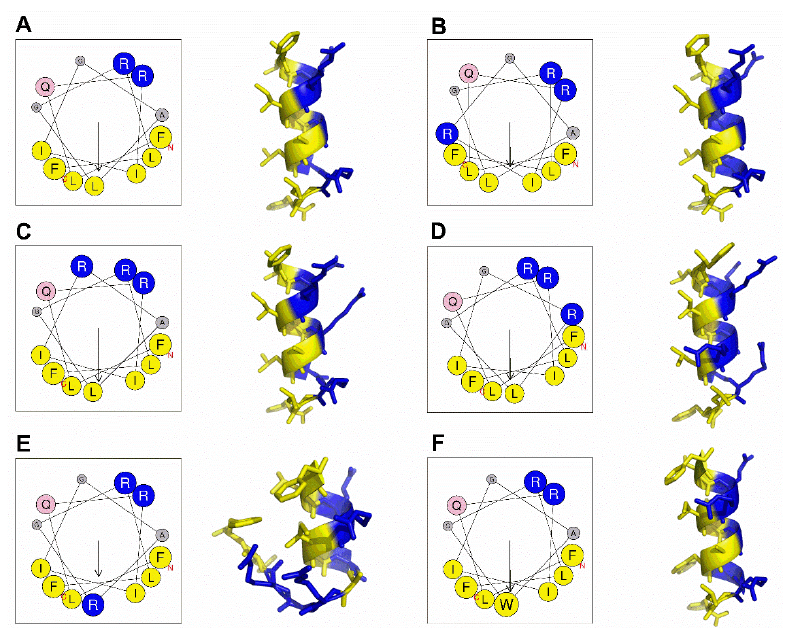
Figure 1. The structure prediction of ( A ) GHaR, ( B ) GHaR6R, ( C ) GHaR7R, ( D ) GHaR8R, ( E ) GHaR9R, and ( F ) GHaR9W. The helical wheels of peptides were predicted by Heliquest (https://heliquest.ipmc.cnrs.fr/). The arrows indicated the direction of the hydrophobic moment. Blue represented hydrophilic amino acid residues, yellow represented hydrophobic amino acid residues. The predicted 3D structures of GHaR and the derived peptides were analyzed by PEP-FOLD (https://bioserv.rpbs.univ-paris-diderot.fr/services/PEP-FOLD3/).